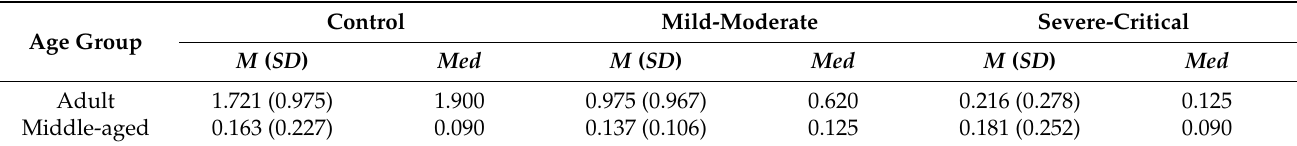
Table 6. Efficiency index d’ for 2AFC phase 2 by age